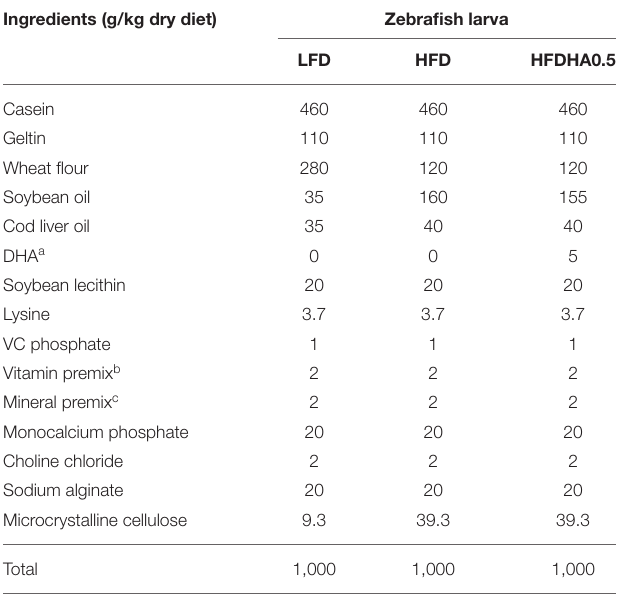
TABLE 4 | Ingredients of experimental diets for germ-free zebrafish (g/kg).